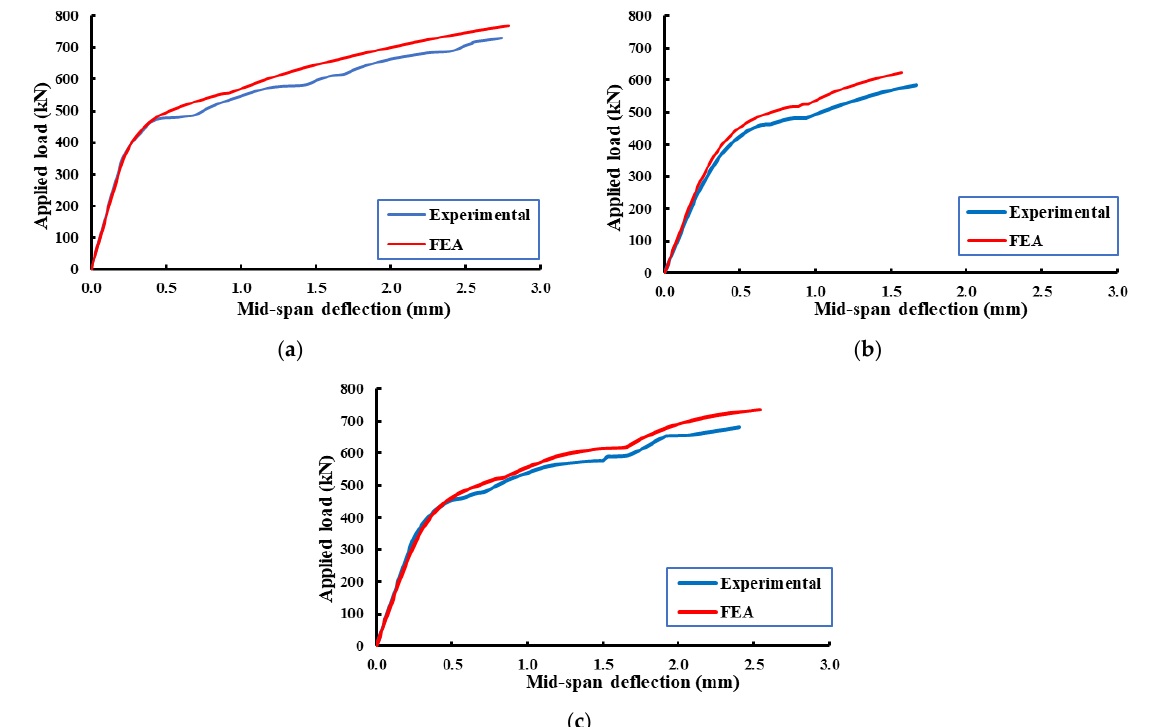
Figure 10. Load mid-span deflection curves for the experimental and FE results. ( a ) Specimen CDB – Solid; ( b ) specimen CDB – O – U; ( c ) specimen CDB – O – S. Table 6. Comparisons between the experimental and FE results.